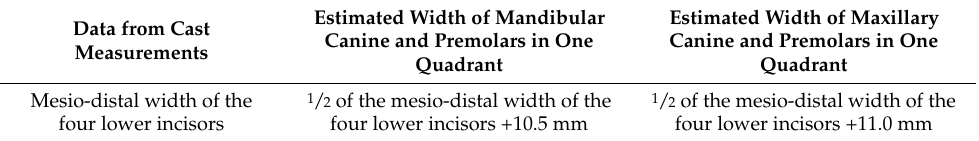
Table 1. Tanaka and Johnston prediction formulas used to estimate the size of unerupted canines and premolars based on the width of the lower incisors (modified from